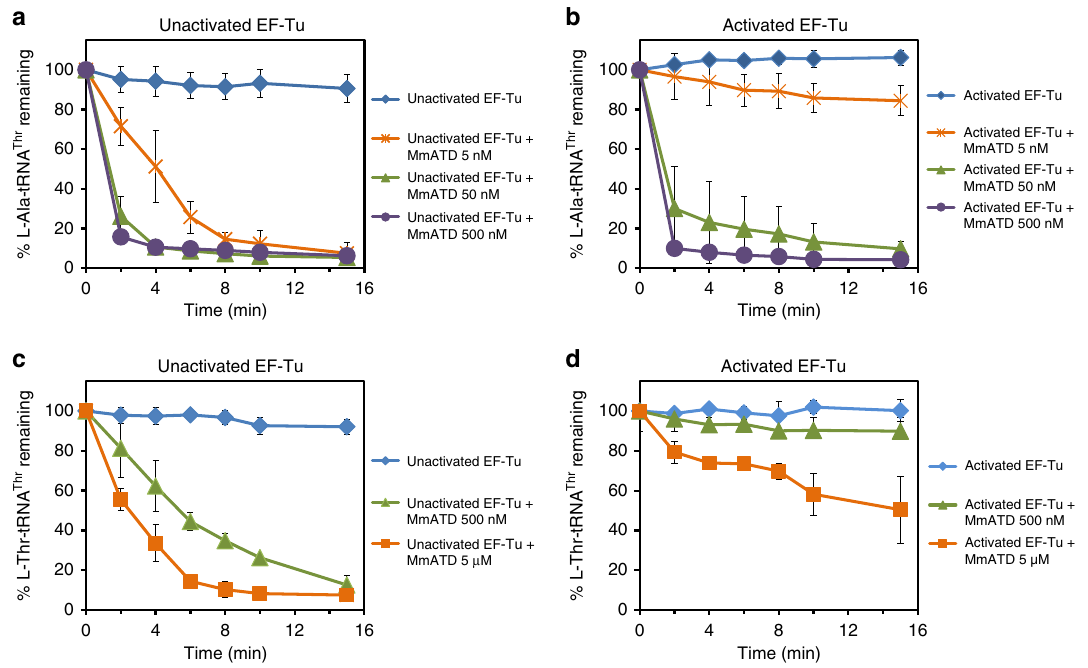
Fig. 6 EF-Tu confers protection on L-Thr-tRNA Thr (G4 (cid:129) U69) against ATD. Deacylation of L -Ala-tRNA Thr (G4 (cid:129) U69) by different concentrations of MmATD in the presence of a unactivated EF-Tu, and b activated EF-Tu. Deacylation of L -Thr-tRNA Thr (G4 (cid:129) U69) by different concentrations of MmATD in the presence of c unactivated EF-Tu, and d activated EF-Tu. Aminoacyl-tRNAs and EF-Tu were used at 200 nM and 2 µ M fi nal concentration, respectively. Error bars denote one standard deviation from the mean of three independent